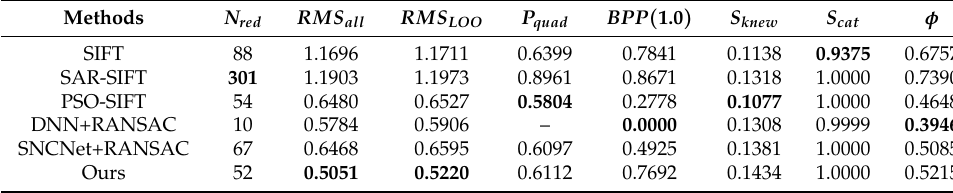
Table 4. The quantitative comparison among six methods on YellowR2 images.